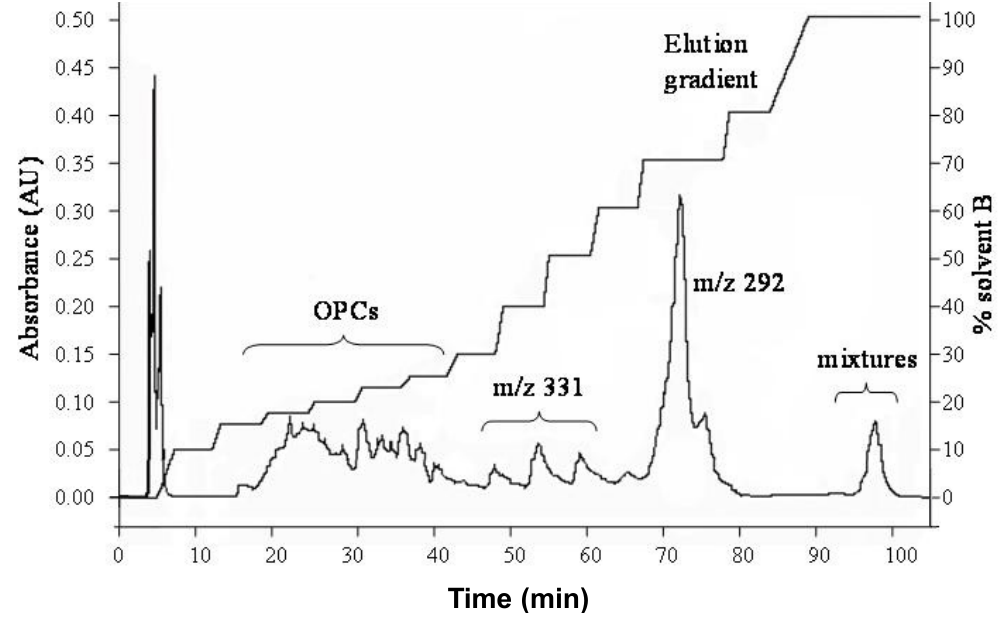
Figure 2. Flash chromatograms of durian seed extract (C-18 column) at a detection wavelength of 280